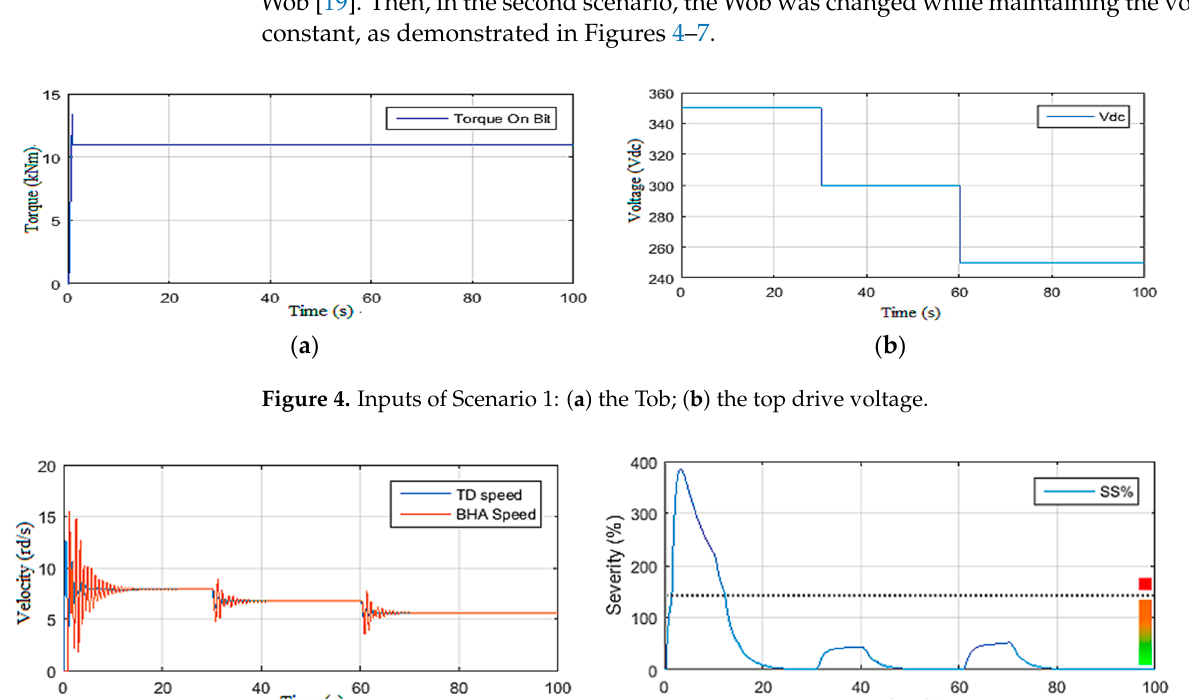
Figure 4. Inputs of Scenario 1: ( a ) the Tob; ( b ) the top drive voltage.